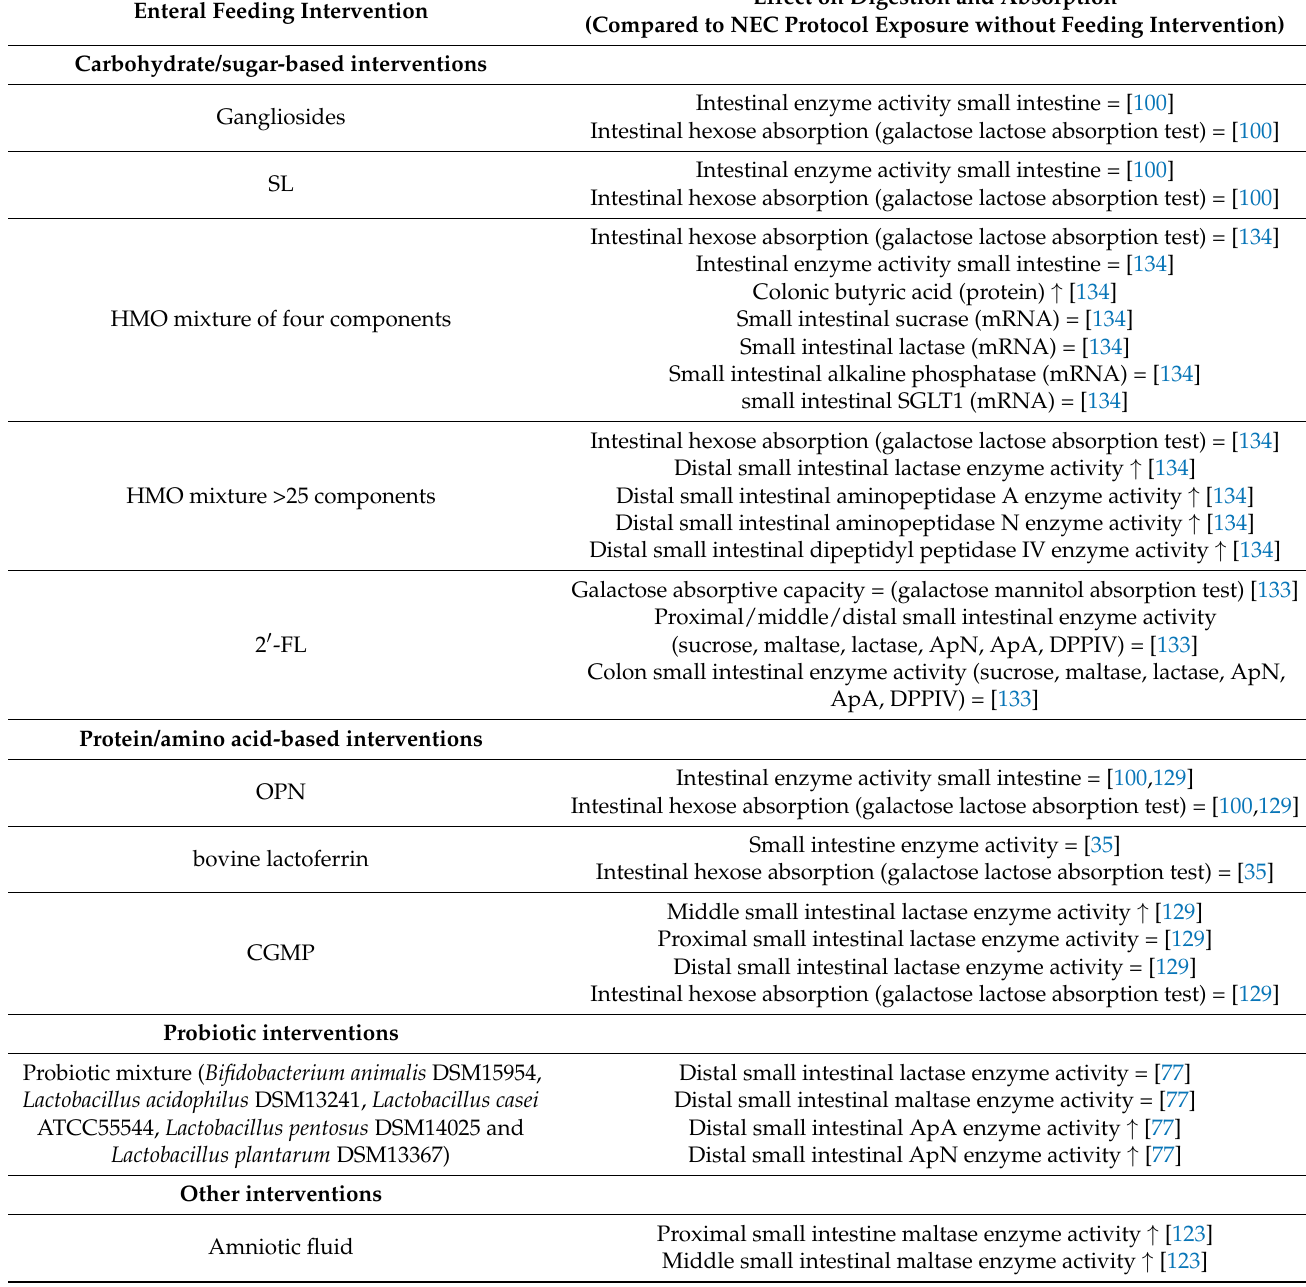
Table 12. Effect of enteral feeding interventions that affect digestion and absorption in experimental animal models of NEC. Effect on Digestion and Absorption Enteral Feeding Intervention (Compared to NEC Protocol Exposure without Feeding Intervention) Carbohydrate/sugar-based